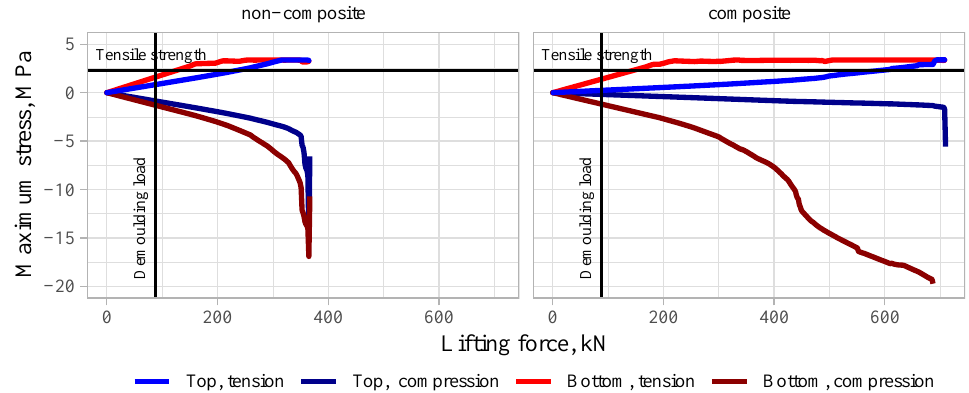
Figure 13. Maximum stresses in top and bottom SFRC layers during the demoulding process.